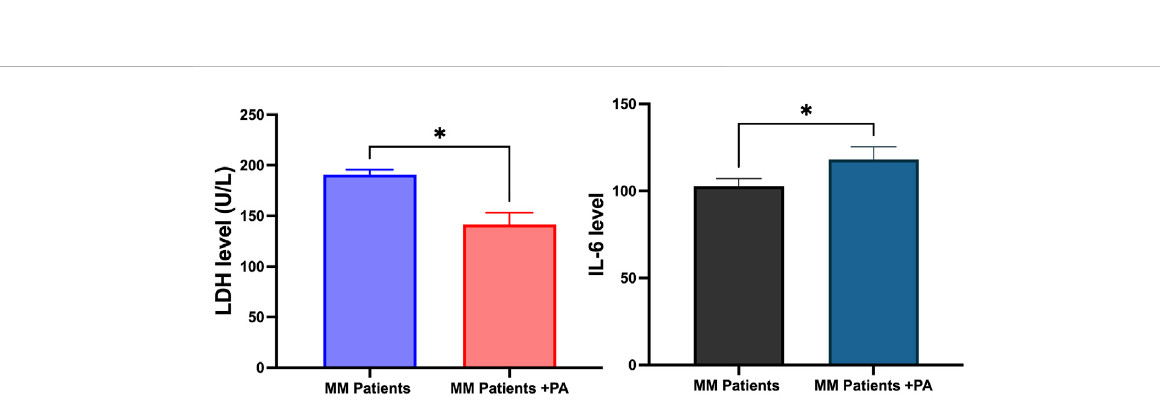
FIGURE 2 Effects of physical activity with MM on LDH and IL-6